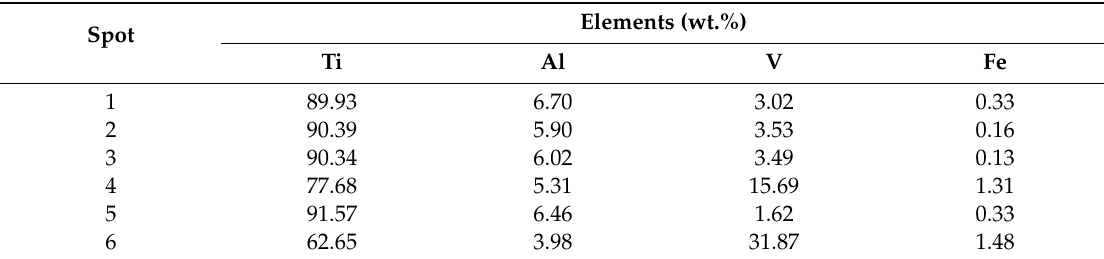
Table 4. Representative elemental distributions for T1 and T3 samples analyzed by TEM-EDS.